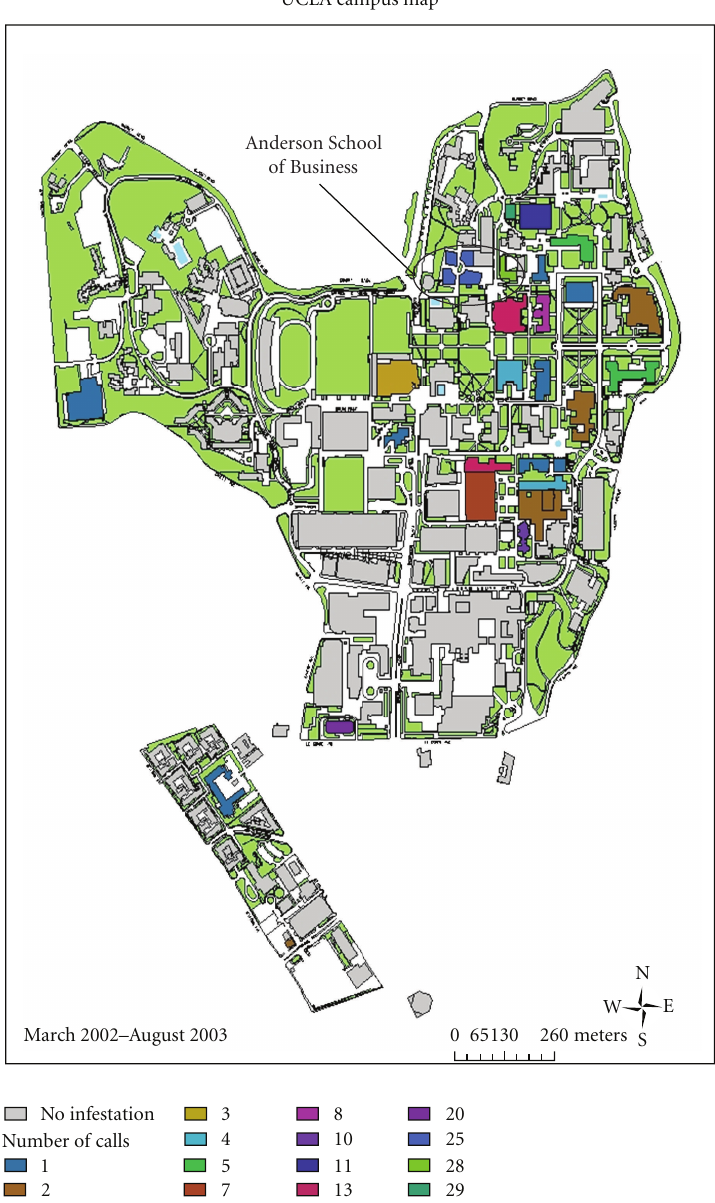
Figure 1: Map of UCLA Linepithema humile infestations in 2002-03. The Anderson School of Business is a complex of 4 structures, but only one of them reported all the